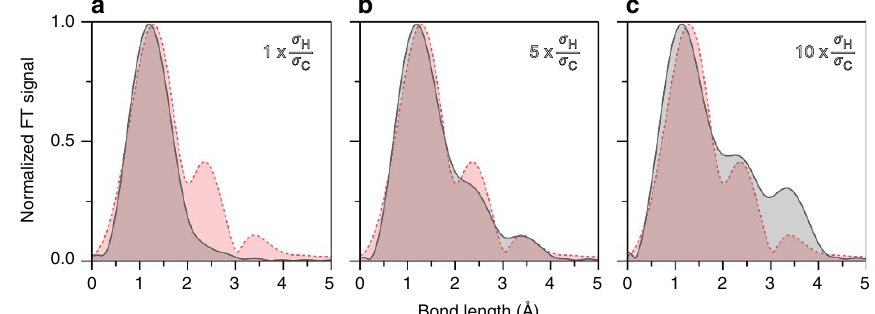
Figure 2 | Limitations of the independent atom model. A comparison of the theoretical (grey, solid throughout figure) and experimental (red, dashed throughout figure) C 2 H 2 þ Fourier spectra. In ( a ) the independent atom model is unmodified while in ( b ) the s H / s C ratio is increased by a factor of five and in ( c ) by a factor of ten. All spectra have been normalized to their maximum values.